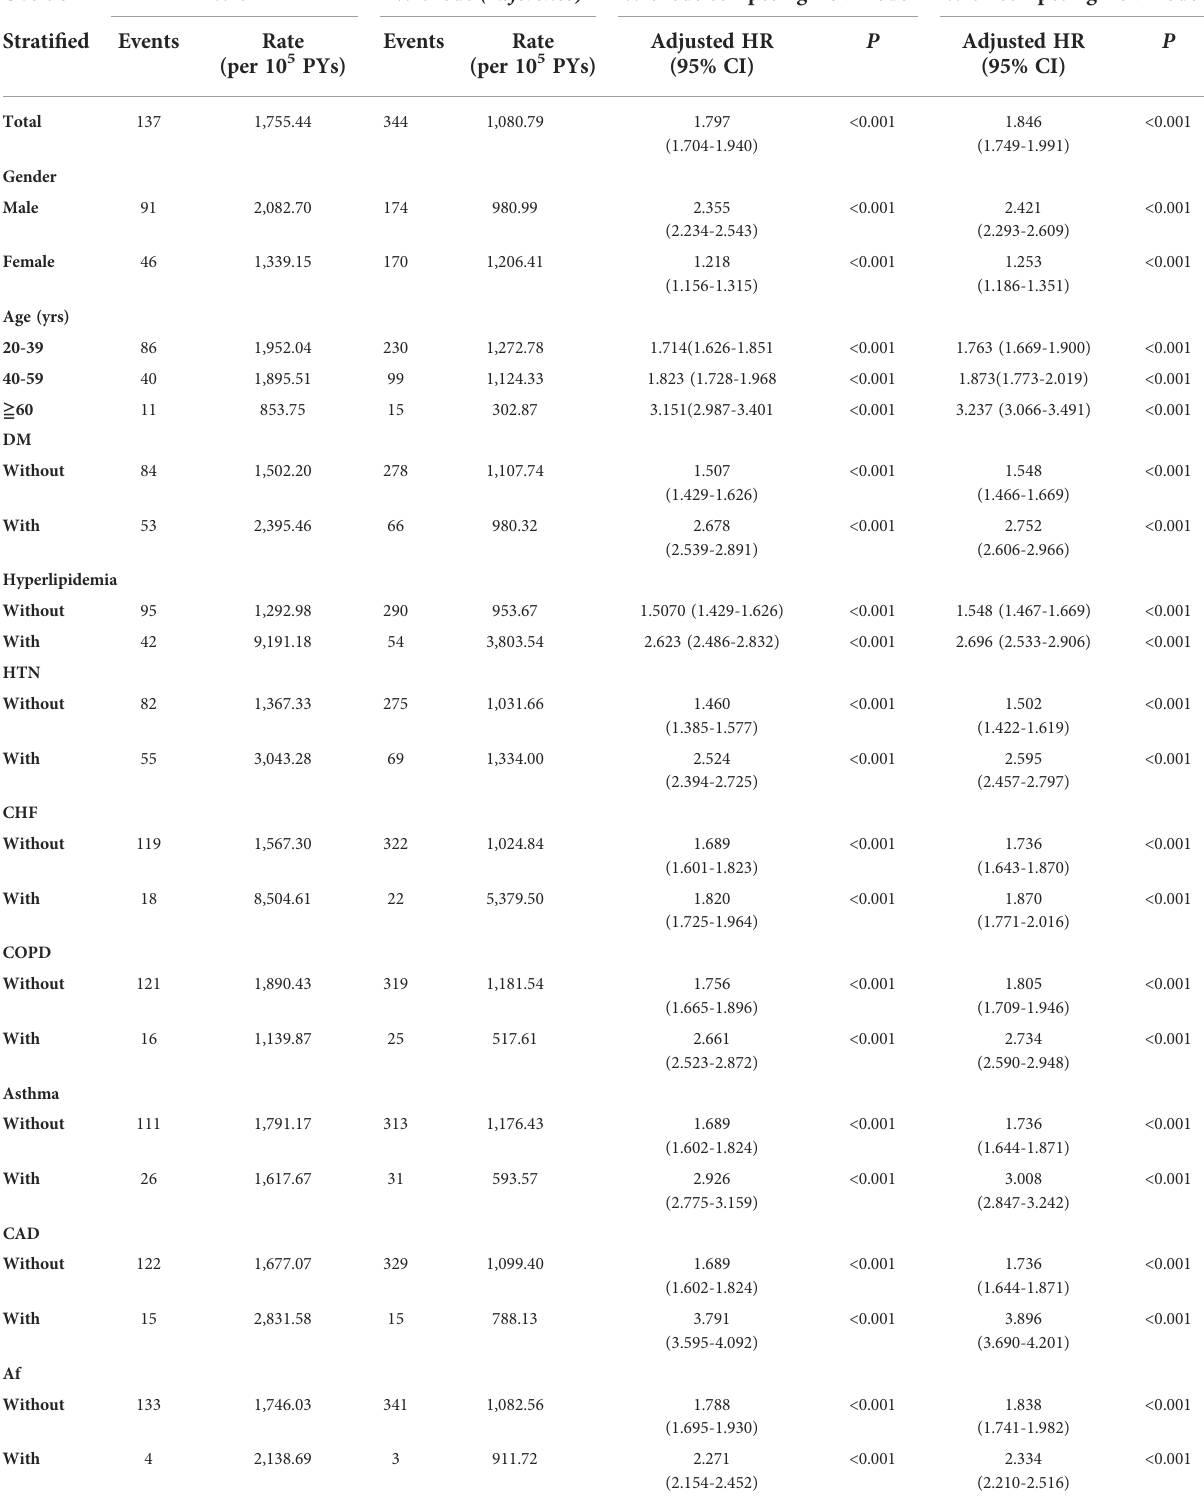
TABLE 3 Risk analysis of stroke after strati fi cation by Cox proportional hazards model with/without Fine & Gray ’ s competing risk model. Uveitis